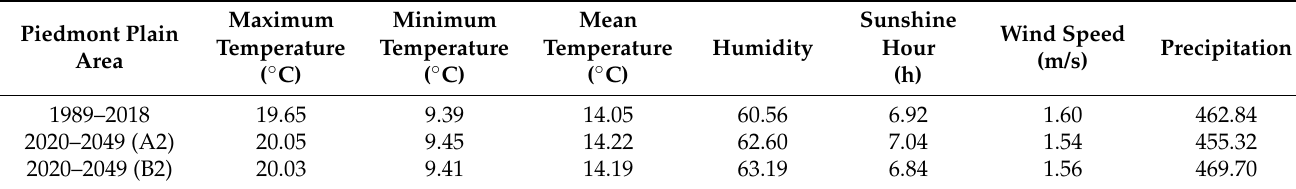
Table 4. Future climate of the piedmont plain area in Hebei Province.